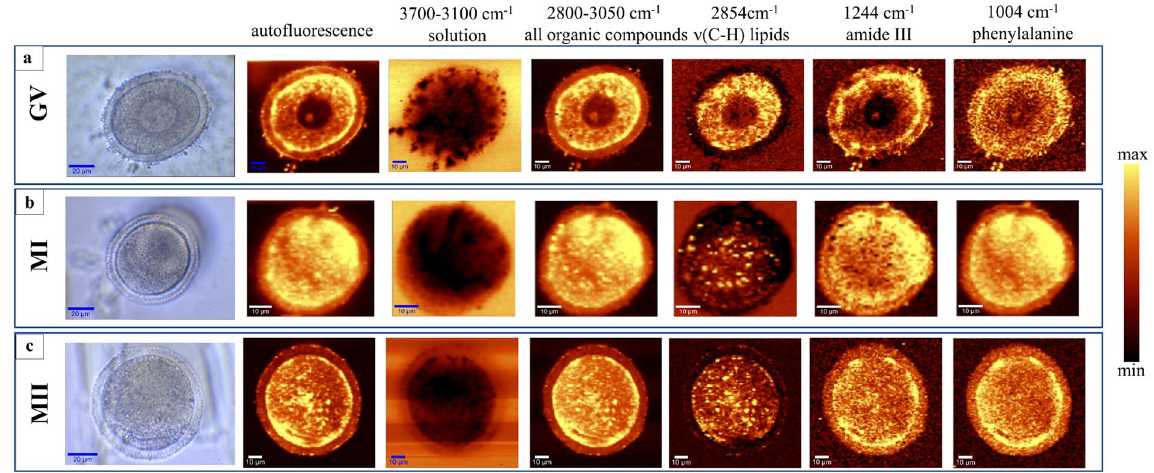
Figure 3. Showing micrographs through the central plane of live GV ( a ), MI ( b ) and MII ( c ) oocytes compared with maps of autofluorescence and maps showing the intensity of Raman spectral bands related to oocyte composition. The yellow color corresponds to the highest relative intensity of autofluorescence or integrated band related to the distribution of different compounds or group of compounds. Spectra used to create the maps were acquired at 1 μ m